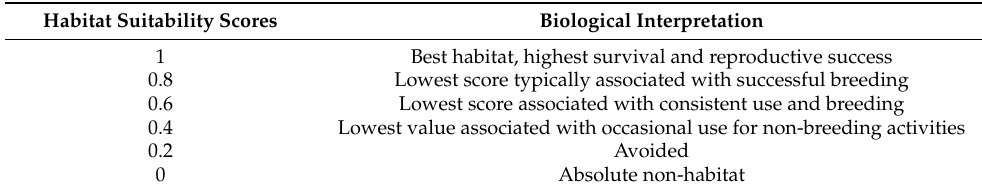
Table 2. Biological interpretation of habitat suitability